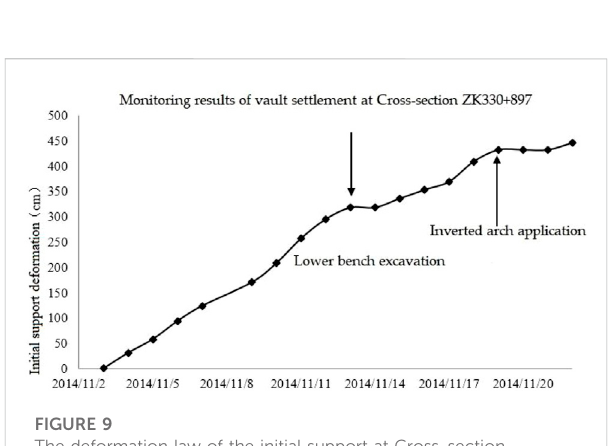
FIGURE 9 The deformation law of the initial support at Cross-section